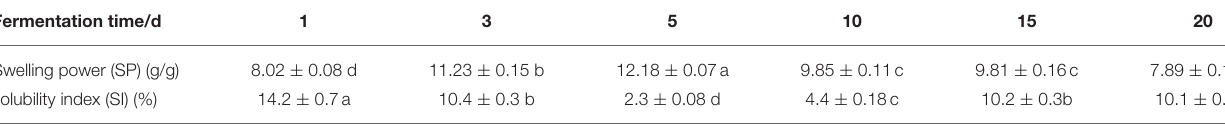
TABLE 3 | Effect of natural fermentation on the pasting properties of corn ballast starch. Fermentation time/d